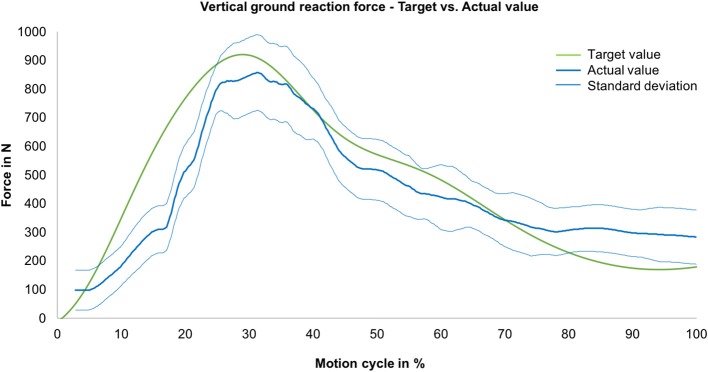
Vertical ground reaction force—comparison between the actual (mean value, blue line) with standard deviation (envelope curve, light blue lines) and target ground reaction forces (measured during MAID study, green line) as a function of the motion cycle (duration: 540 ms) (n = 9).